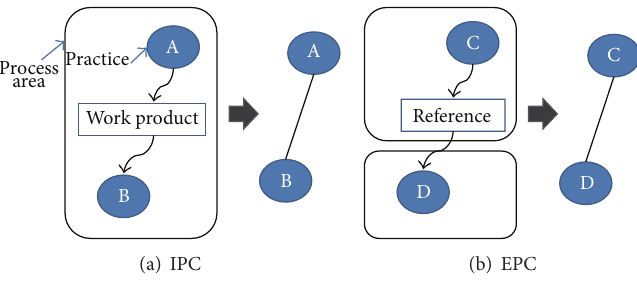
Figure 2: Identifying practice correlations in CMMI.